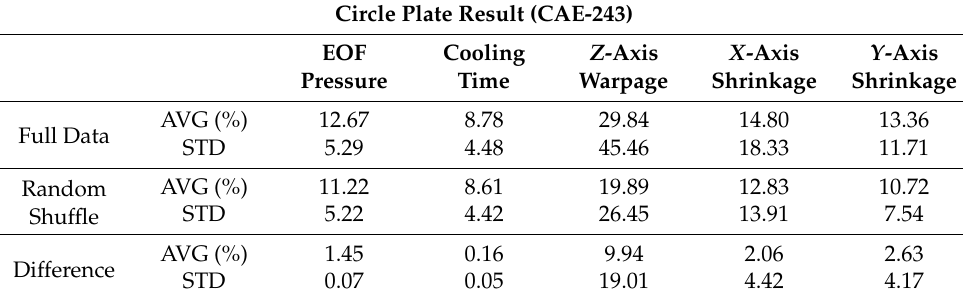
Table 7. CAE data training results for the round flat plate model